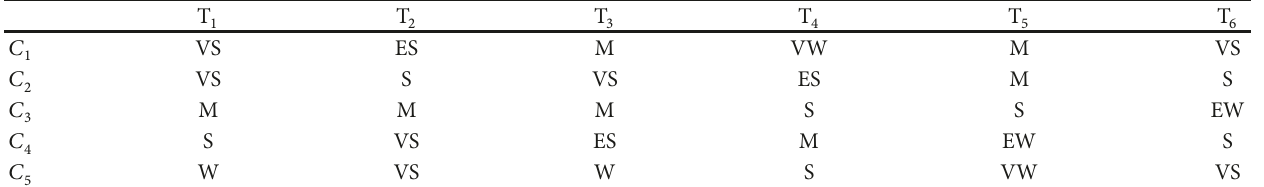
Table 4: The relation matrix 𝐺 1 provided by the 1 st